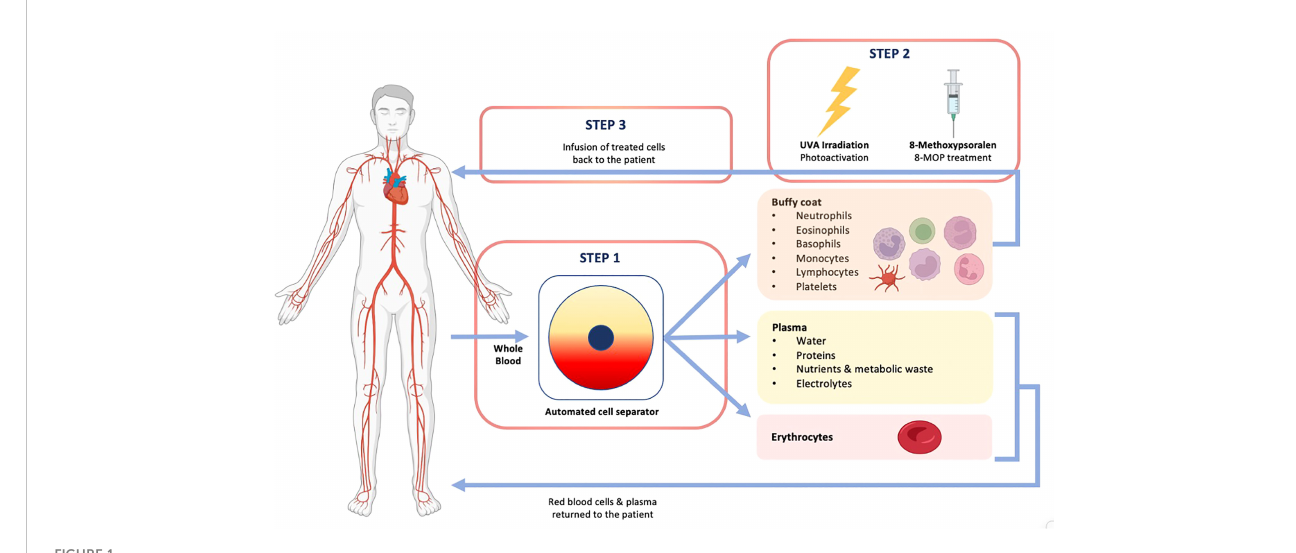
FIGURE 1 Overview of the ECP